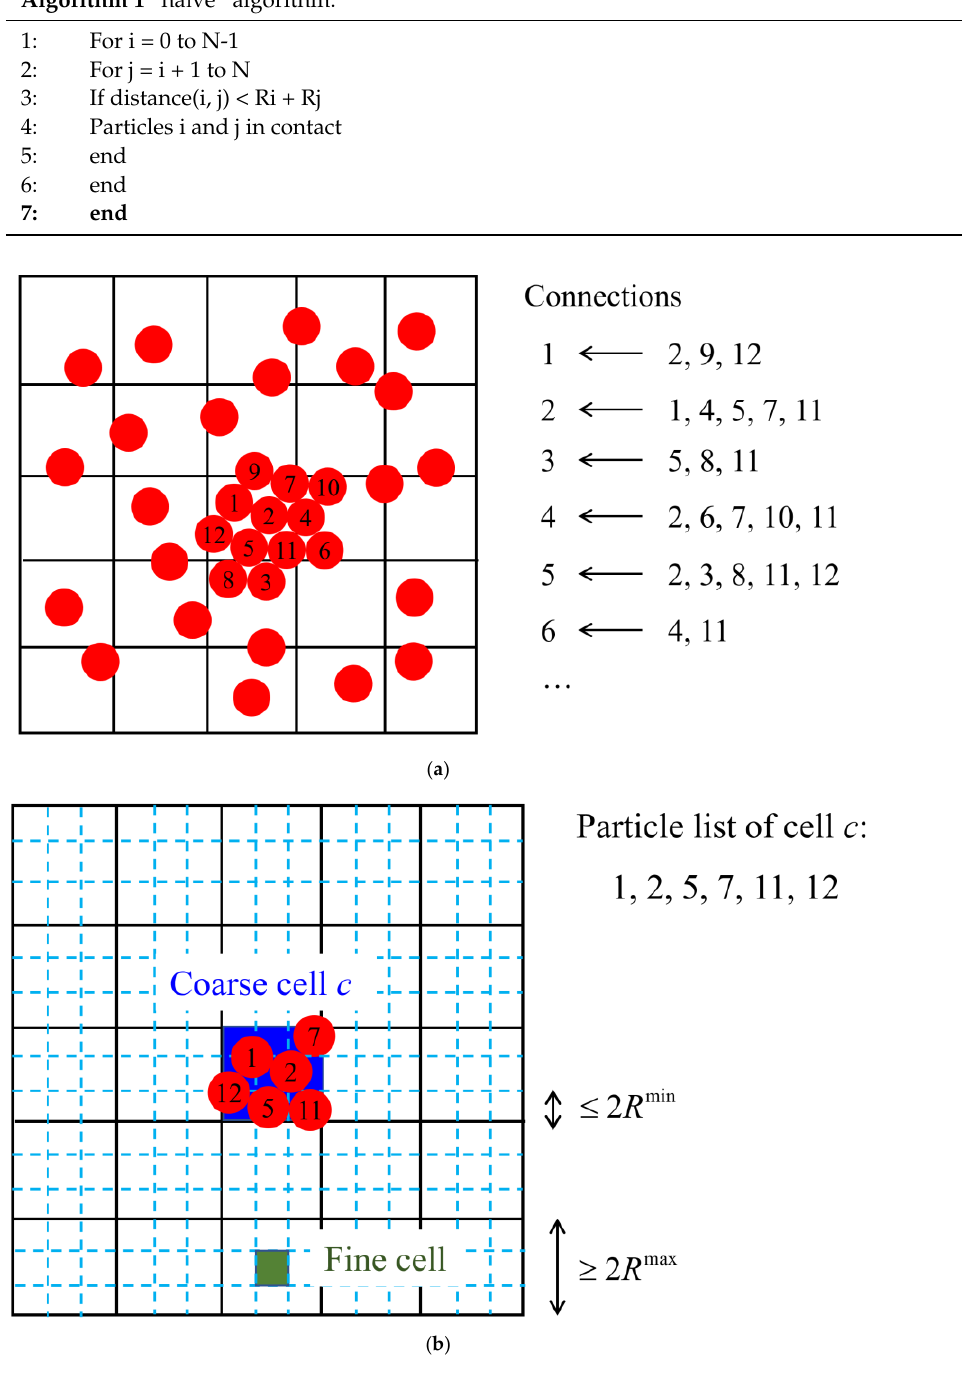
Figure 2. Connection network between particles: ( a ) One set of cells ( b ) hierarchical